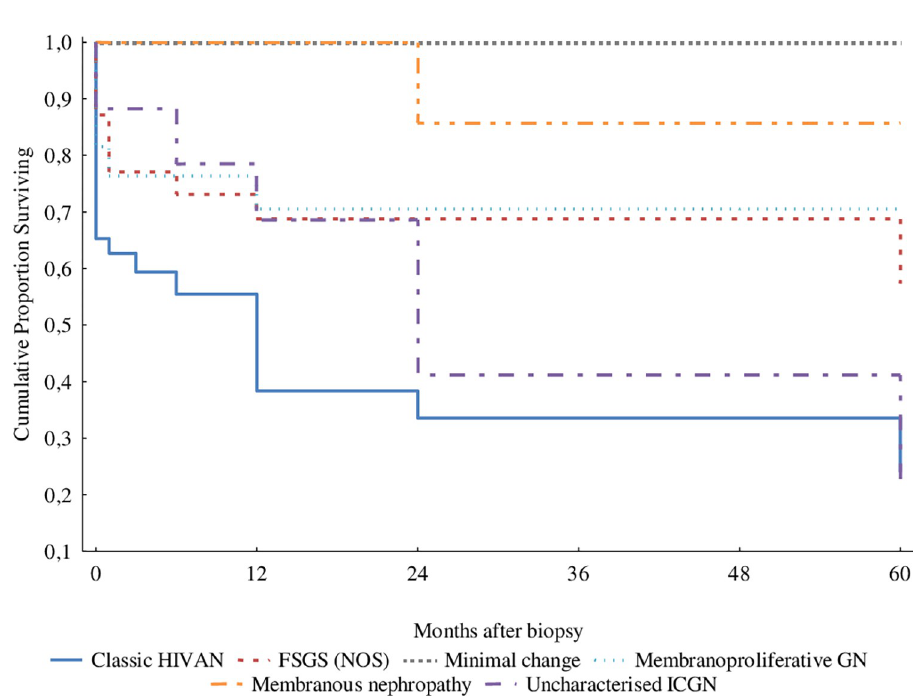
Fig 5. Kidney function survival by histological type in the 229 HIV-positive patients with serial renal function measurement.